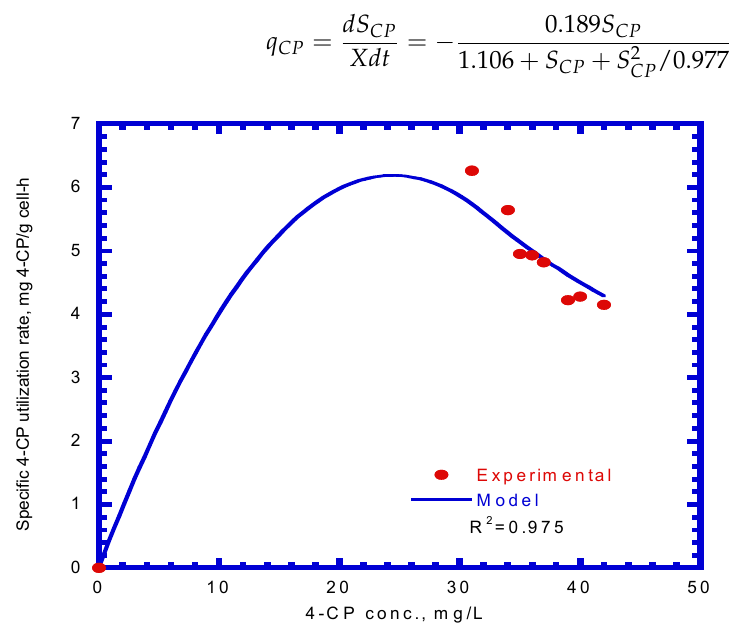
Figure 8. Model-fitted specific 4-CP degradation rate on binary substrates of sodium salicylate and 4-CP to determine the kinetic parameters ( k CP , K S,CP , and K I, CP